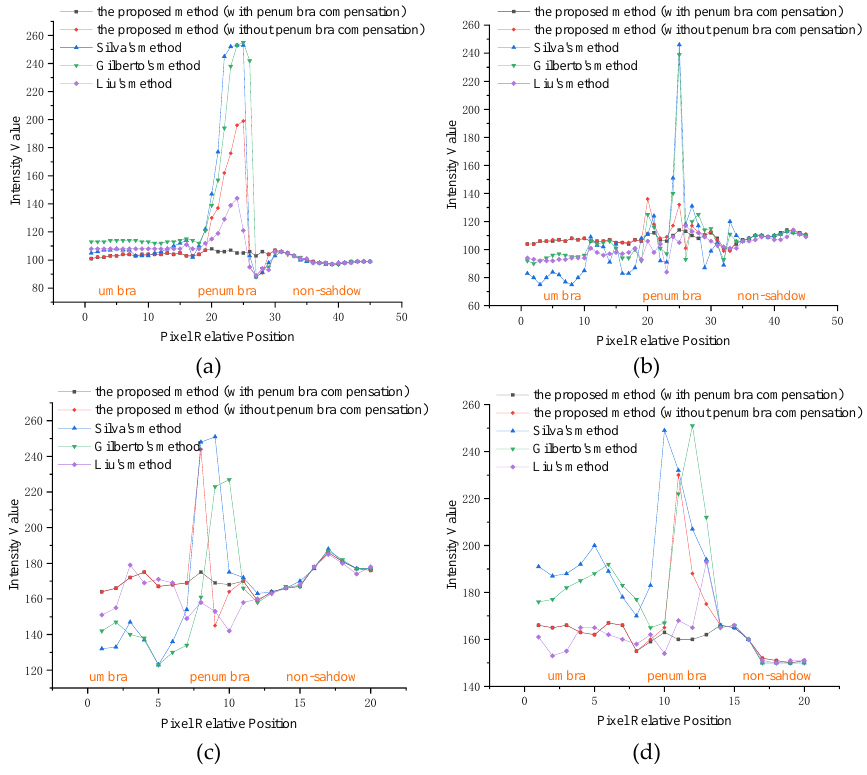
Figure 9. Local enlargement of the compensation results of different methods applied to the four study regions: (a) Silva’s method; (b) Gilberto’s method; (c) Liu’s method; (d) the proposed method (without penumbra compensation); (e) the proposed method (with penumbra compensation).